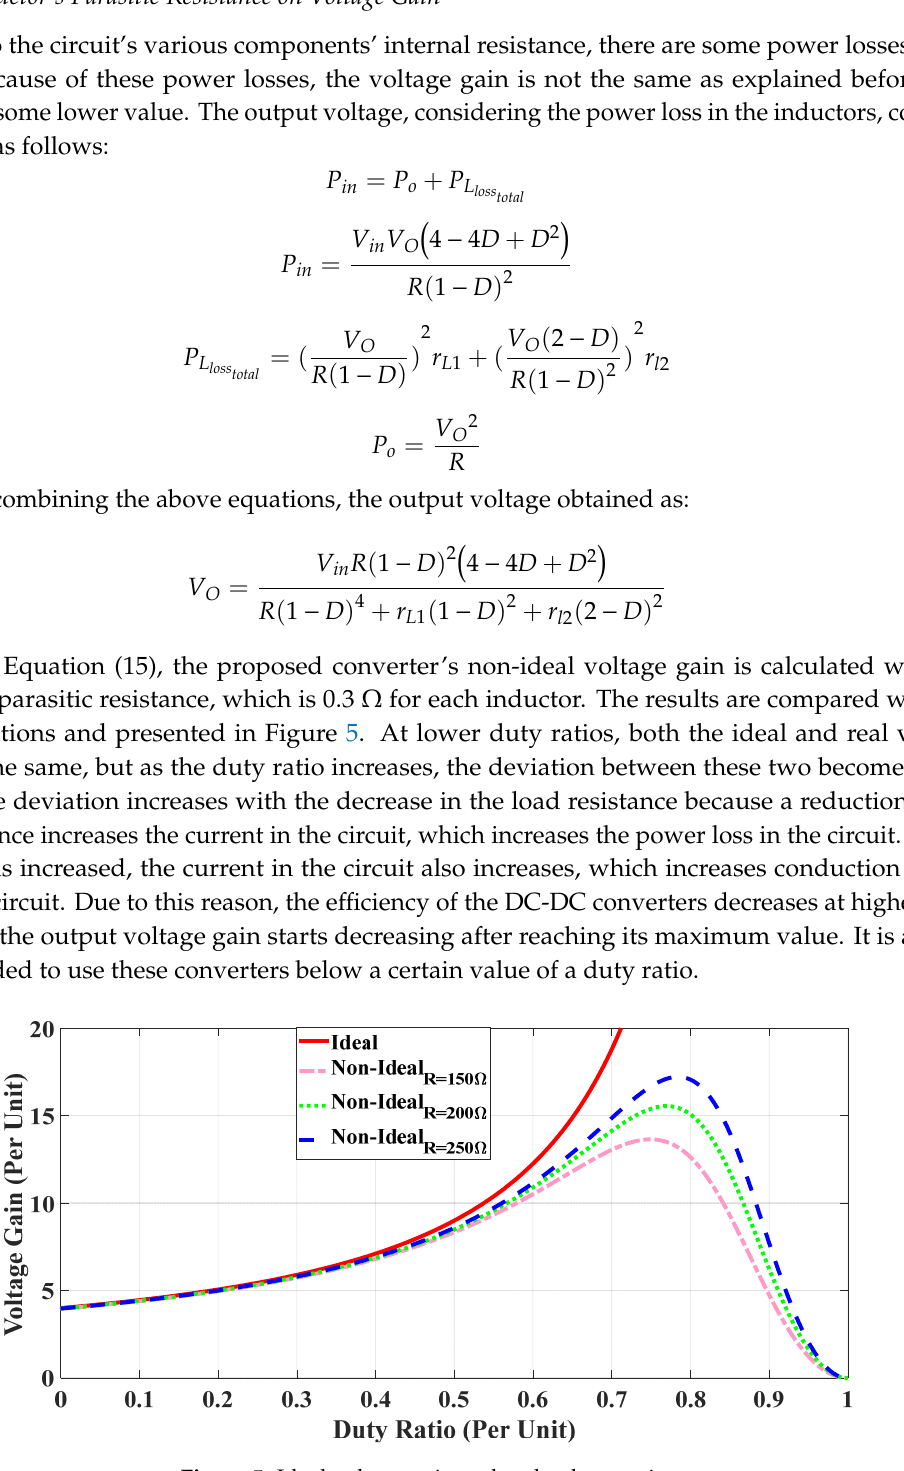
Figure 5. Ideal voltage gain and real voltage gain.